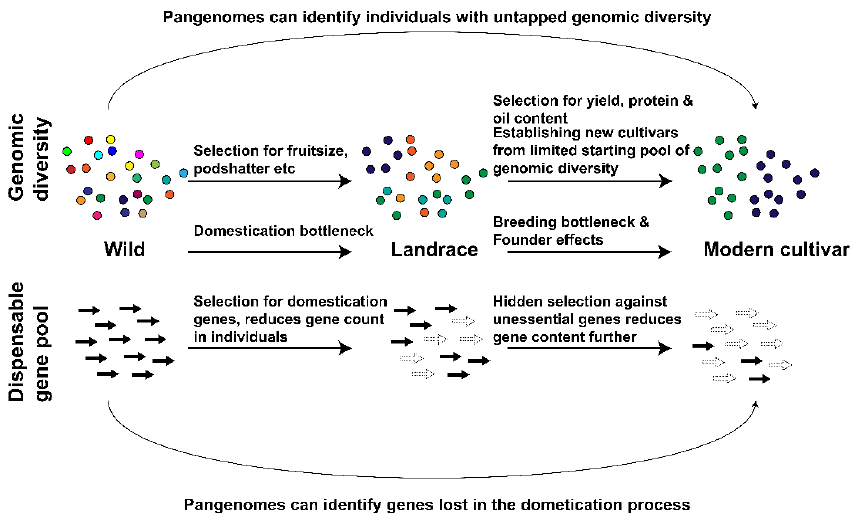
Figure 1. Effects of domestication and breeding bottlenecks on genomic diversity and dispensable genetic content.